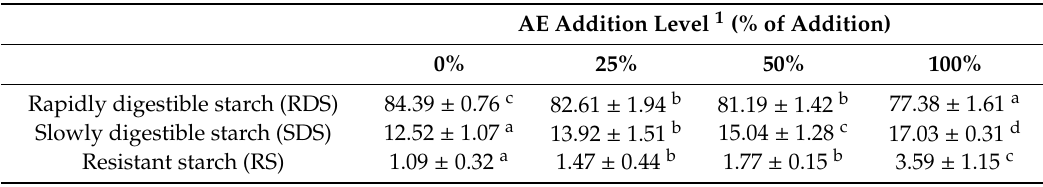
Table 1. Starch fractions content of cooked normal maize starch (g 100 g − 1 dry starch) in the presence of increasing level of artichoke water extract